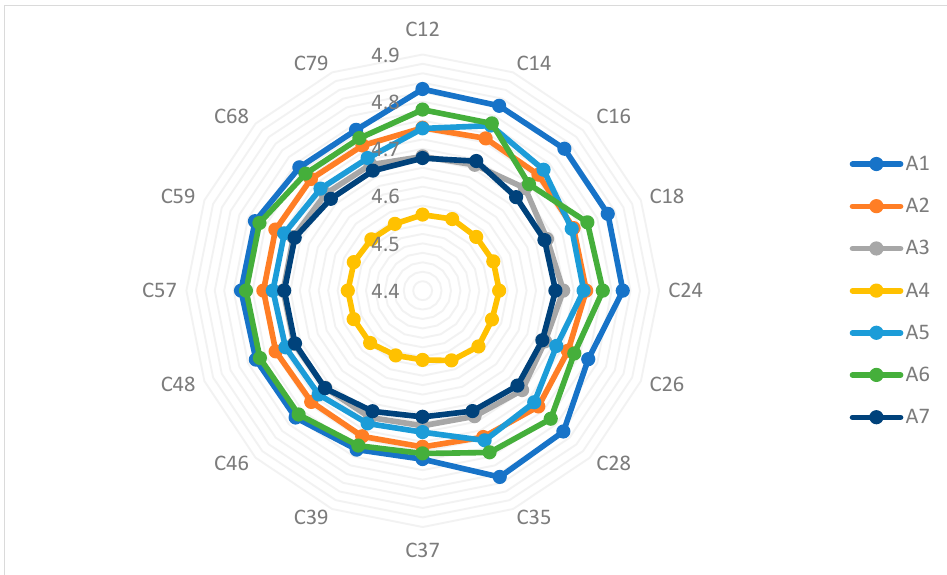
Figure 3. Impact of weights of criteria on final ranks.